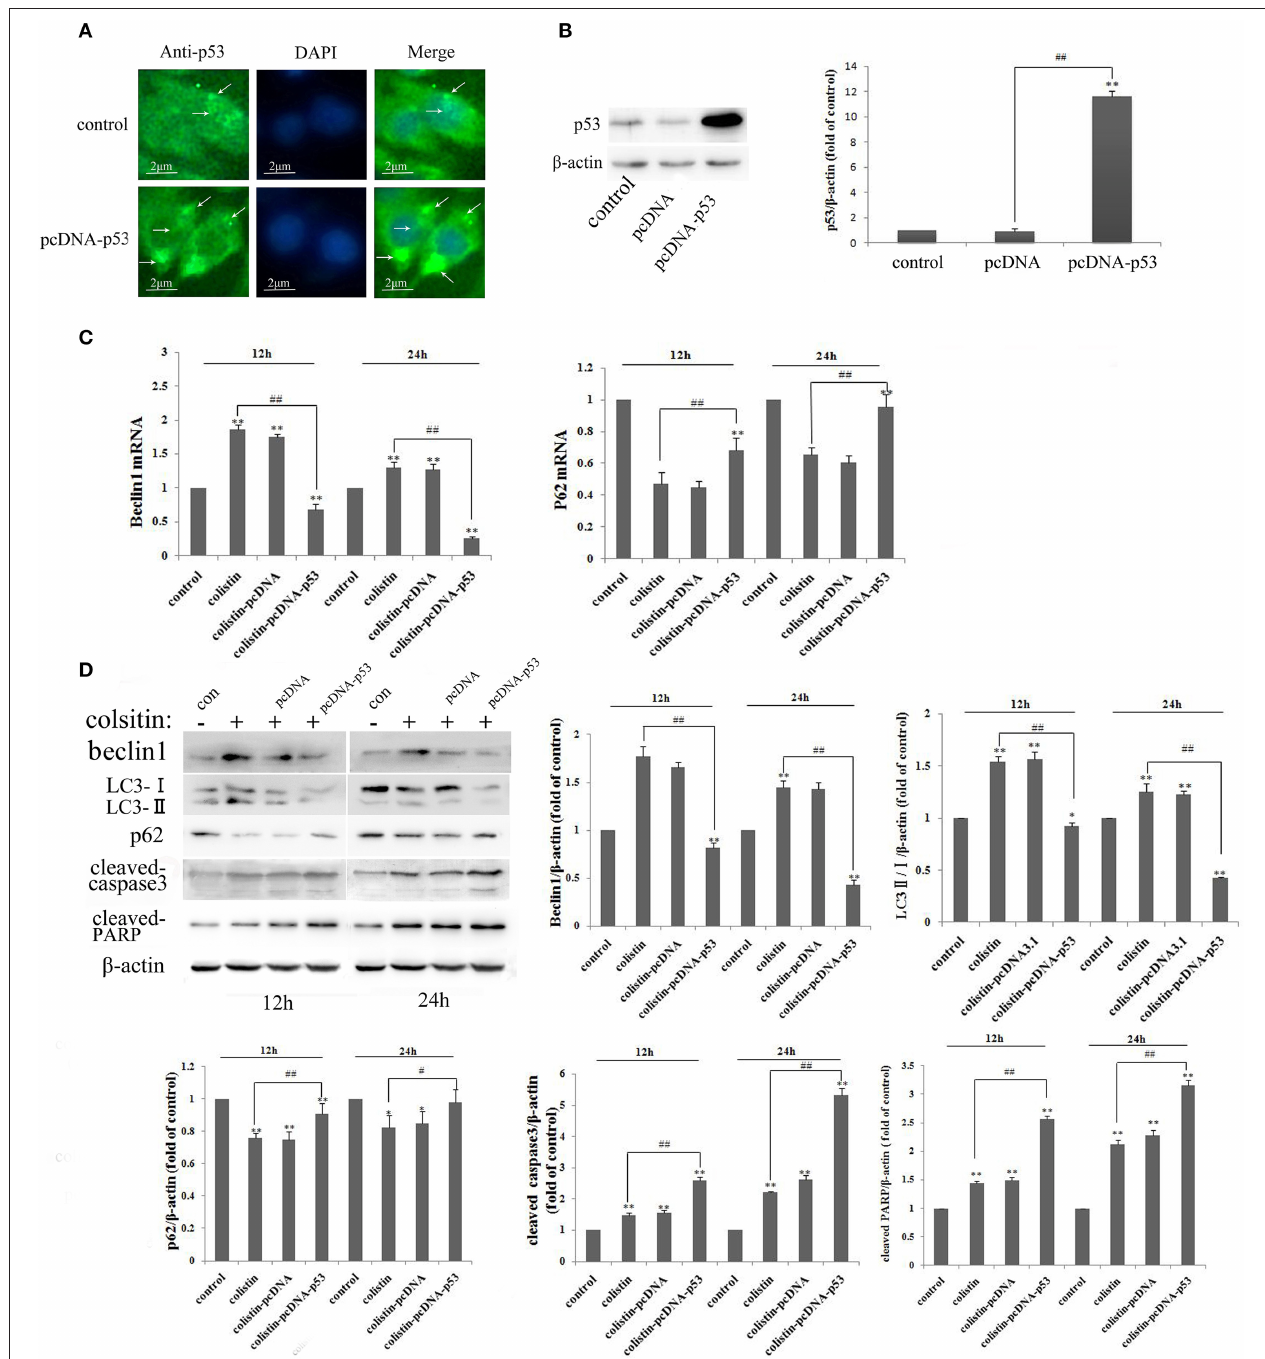
FIGURE 5 | Autophagy and apoptosis in PC-12-p53 cells after colistin treatment. (A) The expression levels of p53 were increased after transfection with a p53 recombinant plasmid, and p53 was localized by immunofluorescence staining with a p53 antibody (green) and nuclear staining with DAPI (blue). Arrows indicate p53 punctum. (B) The expression levels of p53 were assayed by western blot and quantification of the p53 protein levels. ** p < 0.01 vs. control group; ## p < 0.01 vs. inter-groups. (C) The expression levels of autophagy-related genes, including beclin1 and p62, were determined by RT-PCR following colistin treatment for 12 and 24h. Bar graph represents the mean percentage ± SD of autophagy cells ( n = 3). ** p < 0.01 vs. control group; ## p < 0.01 vs. inter-groups. (D) The expression levels of beclin1, p62, the ratio of LC3-II/I and cleaved caspase3 and PARP by western blot. The β -actin level was used as the internal standard, and shows the quantitative results of the expression levels, respectively. * p < 0.05; ** p < 0.01 vs. control group; # p < 0.05; ## p < 0.01 vs. colistin alone group.